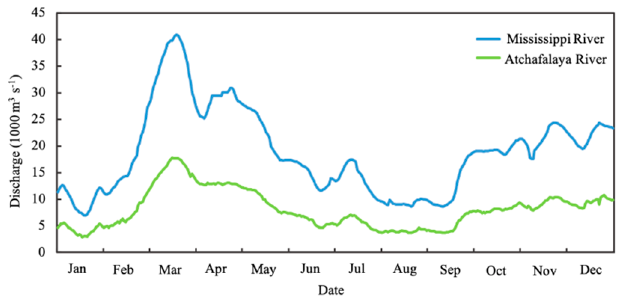
Figure 8. River discharge data in 2018, acquired from Gate ID 01100Q and 03045Q. Blue line presents Mississippi River discharge and green line presents Atchafalaya River discharge.